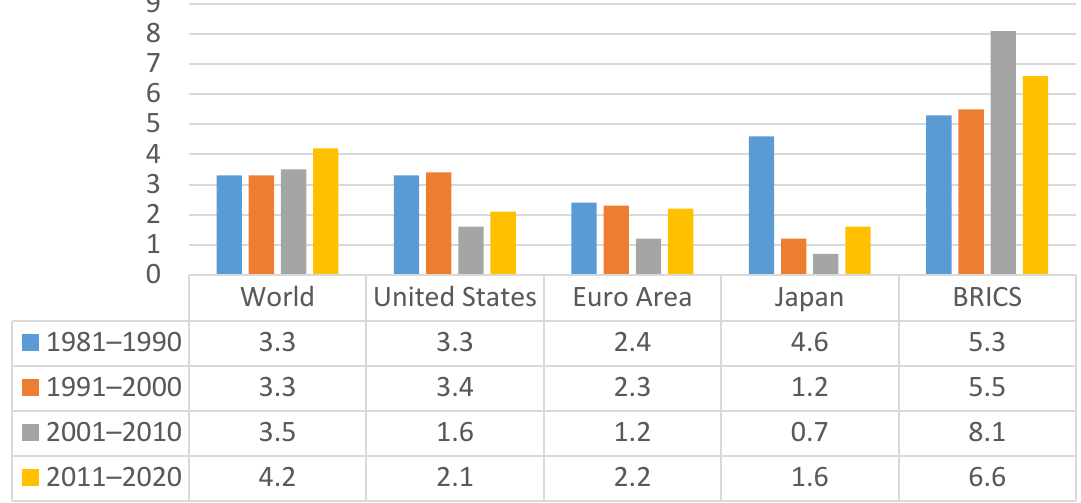
Figure 1. Average GDP (actual and